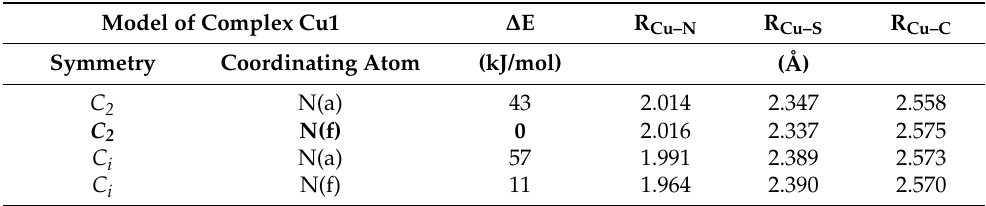
Table 3. DFT geometry optimization results for considered mononuclear models of Cu1 complex. The most energy-stable model is marked in bold.